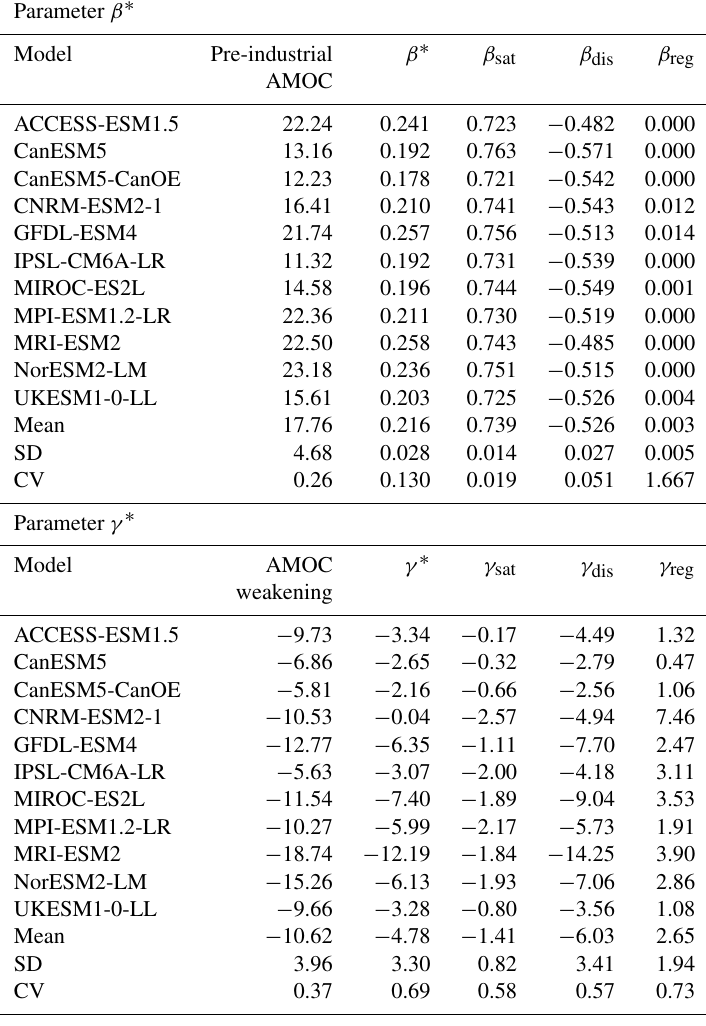
Table 3. Carbon–concentration feedback parameter based on carbon storage, β ∗ (PgCppm − 1 ), and carbon–climate feedback parameter based on carbon storage, γ ∗ (PgCK − 1 ), in the Atlantic Ocean, and the contribution from the saturated, disequilibrium and regenerated carbon pools, along with the strength of the Atlantic Meridional Overturning Circulation (AMOC) in sverdrups, in the pre-industrial era and its weakening relative to the pre-industrial era due to climate change. The strength and weakening of the AMOC are estimated as the maximum pre-industrial AMOC and maximum AMOC change between 30 and 50 ◦ N, respectively (Figs. 8 and 9). Results are shown for 11 CMIP6 Earth system models, along with the inter-model mean, standard deviation and coefficient of variation (CV), estimated as the standard deviation divided by the mean. The estimates are based on the fully coupled simulation (COU) and the biogeochemically coupled simulation (BGC) under the 1%yr − 1 increasing CO 2 experiment. Diagnostics are from years 121 to 140 (the 20 years up to quadrupling of atmospheric CO 2